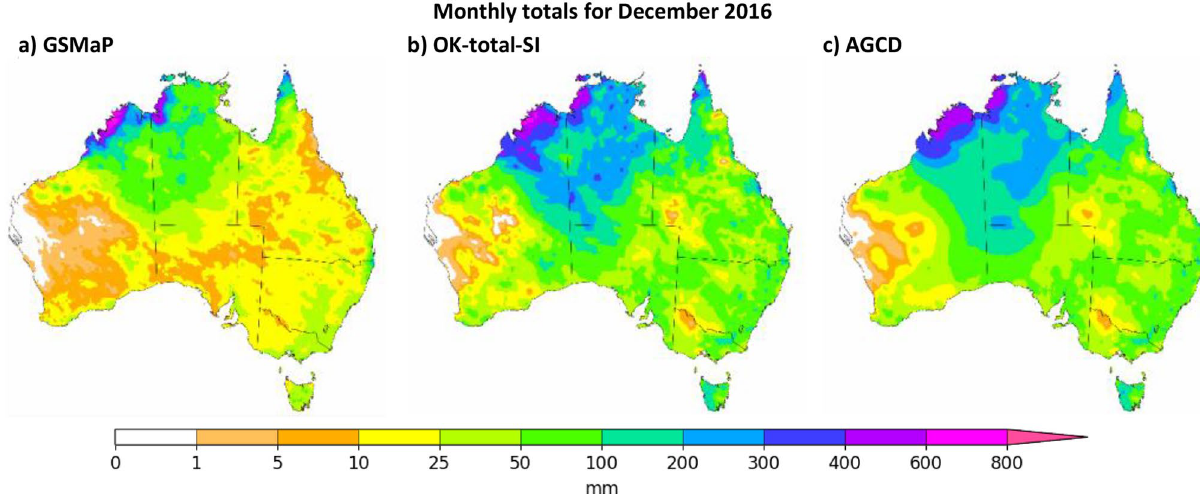
Figure 9. Visual comparison of December 2016 as represented by GSMaP-SI, OK-total-SI and AGCD. The greatest difference is over the north-east interior of WA and the south-west interior of NT where OK-total-SI, and to a lesser extent GSMaP-SI, have greater totals than AGCD. This is the region where ex-TC Yvette traversed after it crossed the coast, and is also where rain gauge density is extremely low. Figure created using Matplotlib 3.3.3 on Python.